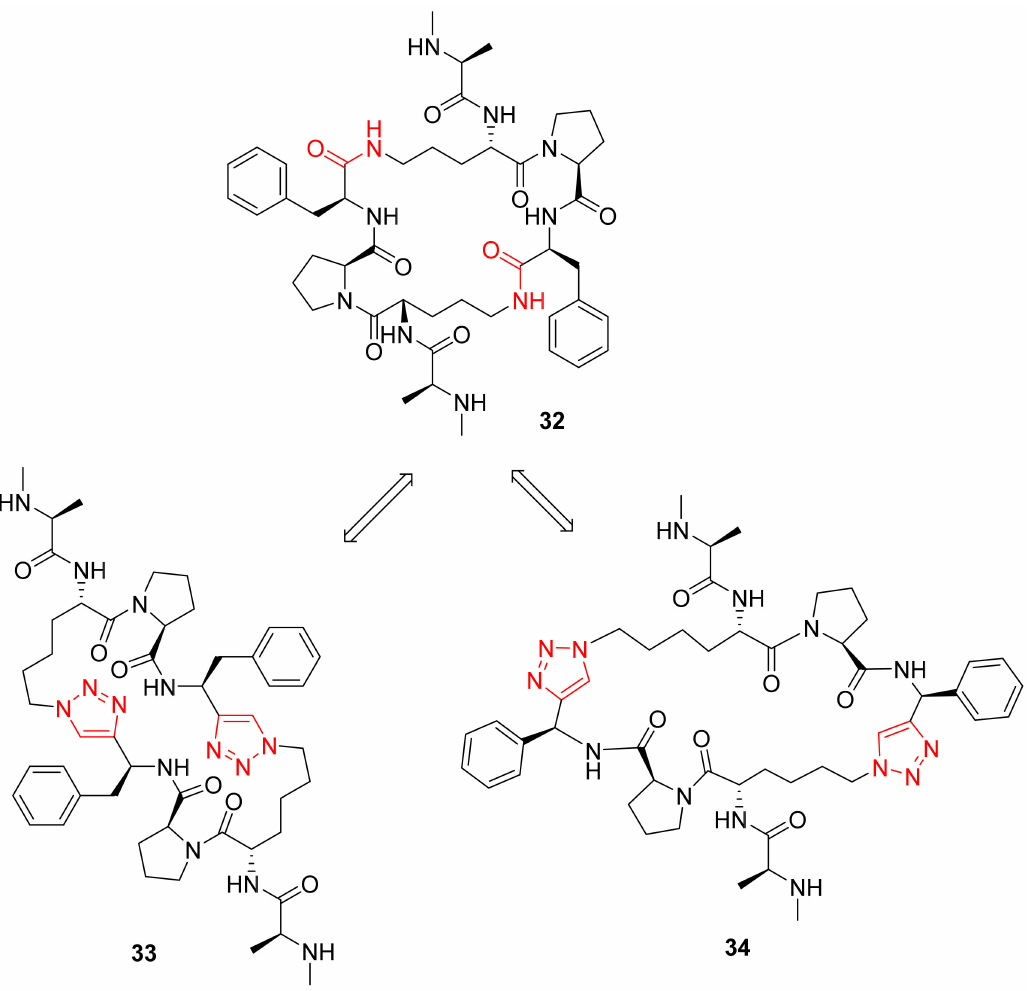
Figure 14. Structure of the Smac dimer 32 and its two derivatives, 33 and 34